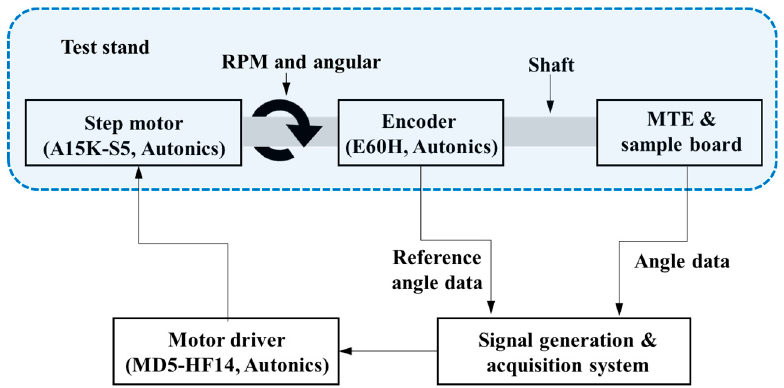
Figure 8. Experimental environment block diagram.